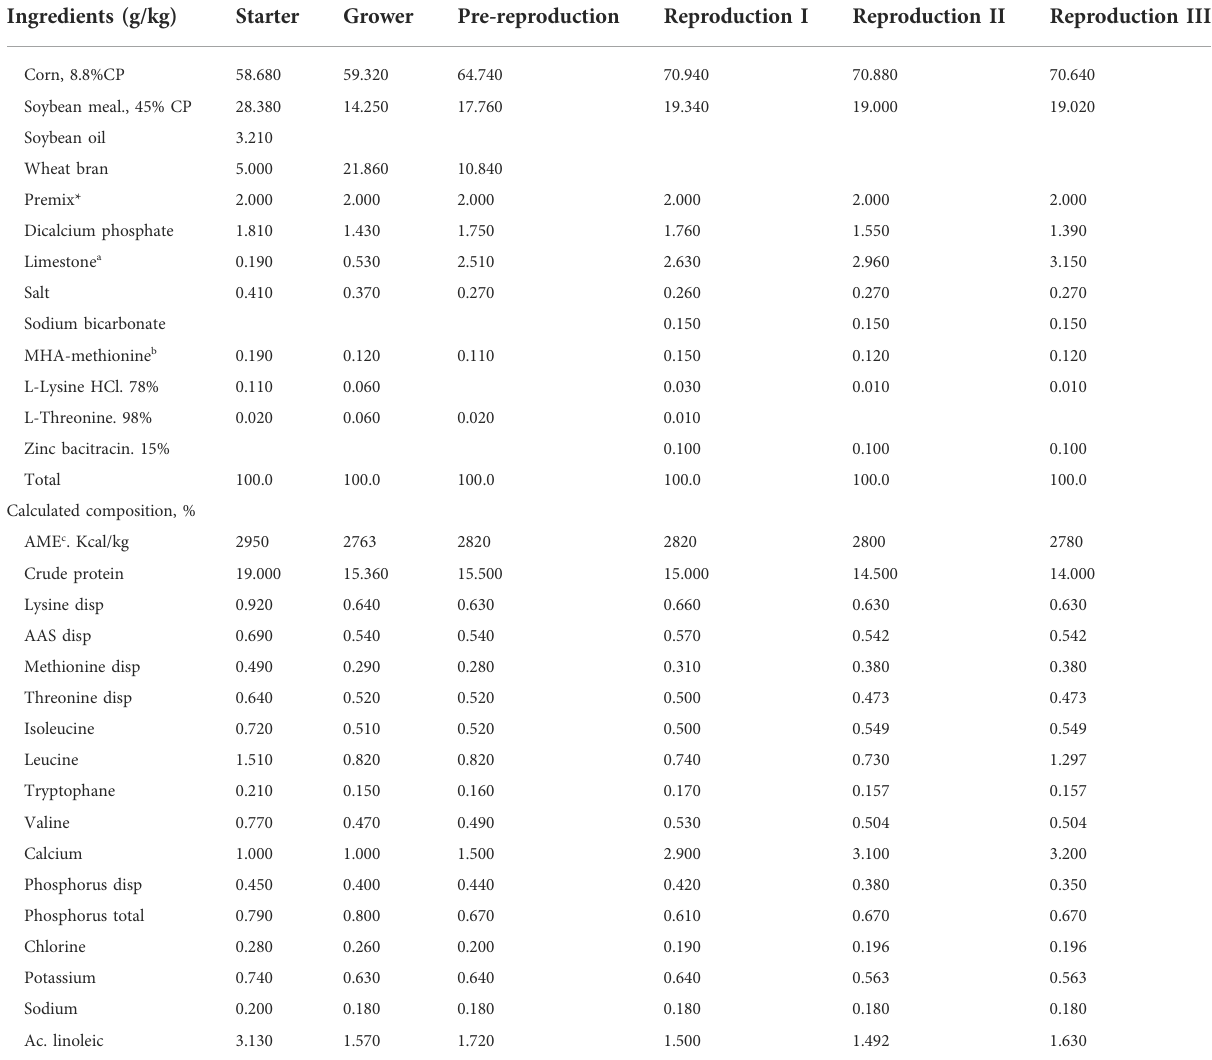
TABLE 1 Composition of the basal diet for all stages of